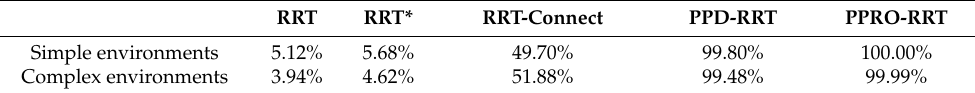
Table 1. The success rate of various algorithms in two kinds of experimental environments. RRT RRT* RRT-Connect PPD-RRT PPRO-RRT Simple environments 5.12% 99.99% Table 1 indicates the success rate of various path planning algorithms in two kinds of experimental environments. The experimental results showed that the success rates of the PPD-RRT and PPRO-RRT path planning algorithms were significantly higher than those of the other algorithms. The success rates of the PPD-RRT and PPRO-RRT algorithms